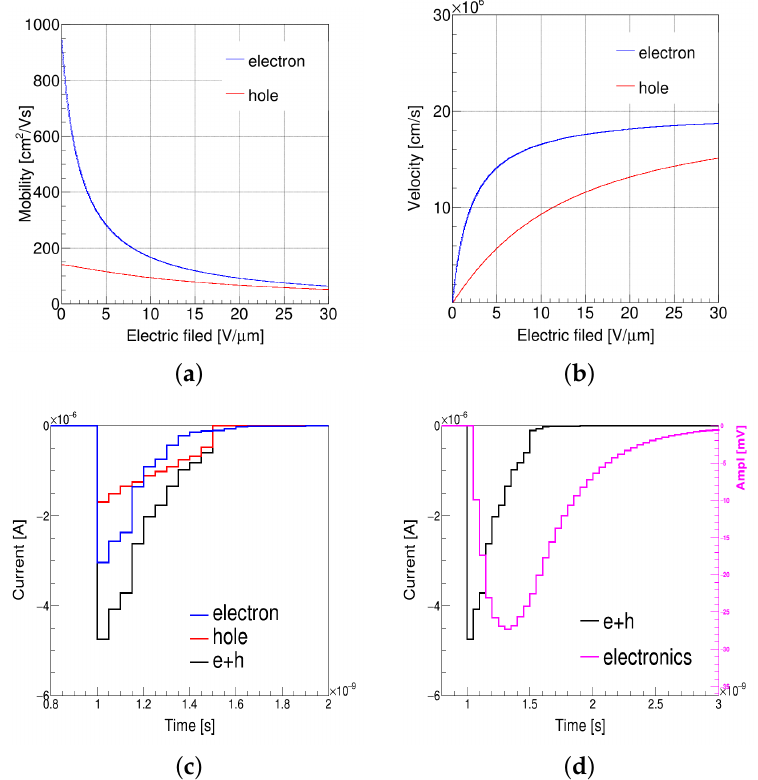
Figure 4. (Color online.) ( a ) The mobility model and ( b ) the velocity model of electron (blue) and hole (red) for 4H-SiC used in RASER. ( c ) The distribution of induced current for electron (blue), hole (red), and electron plus hole (black). ( d ) The distribution of induced current for electron plus hole (black) and amplitude after electronics